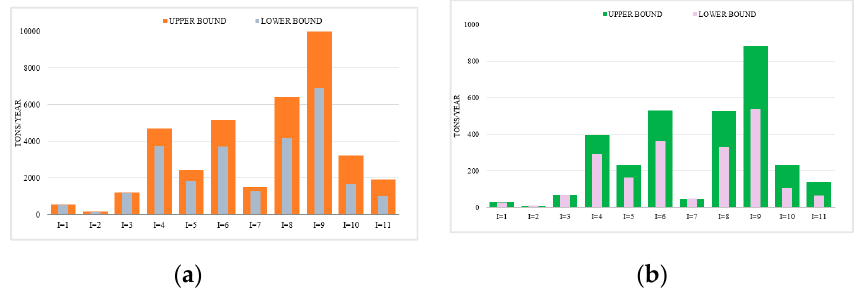
Figure 5. The amounts of COD and ammonia nitrogen flow into the river on different control units in the Yinma River Basin in the second planning period. ( a ) The amount of COD flow into the river in the second planning period; ( b ) The amount of ammonia nitrogen flow into the river in the second planning period.